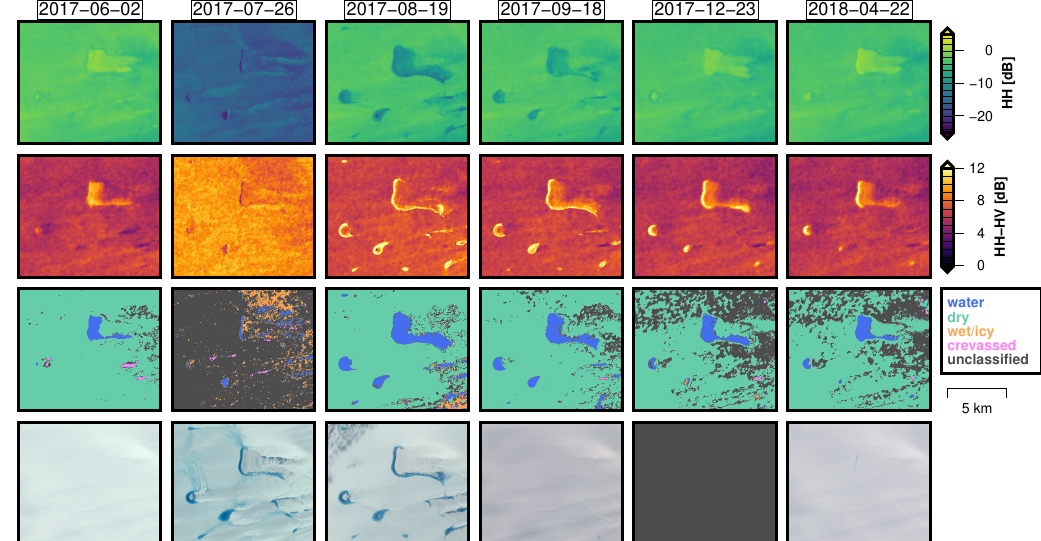
Figure 3. Sequence of scenes near the margin of the 79°North Glacier, (79NG) (dashed square in Figure 1) in S1 polarimetric SAR (HH and HH–HV), our classification result and corresponding S2 optical